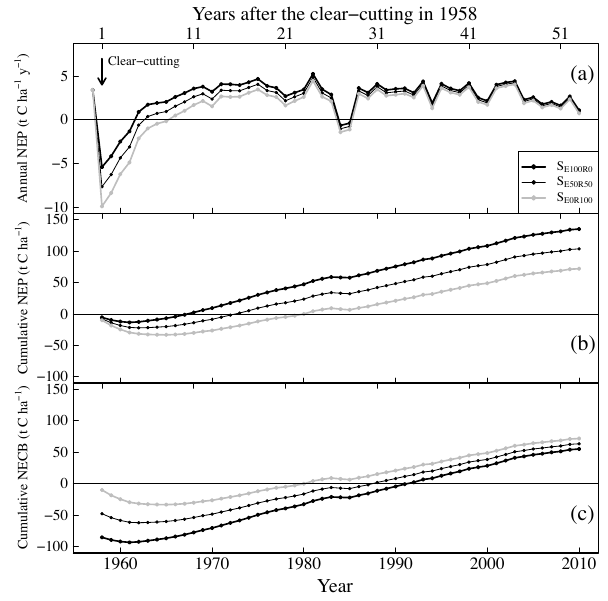
Figure 3. Time course of (a) annual net ecosystem production (NEP), (b) cumulative NEP, and (c) cumulative net ecosystem car- bon balance (NECB) at the Tomakomai site. These were simulated on the basis of the four treatment scenarios for clear-cutting and residues. Clear-cutting was not implemented in the non-disturbance scenario. S E0R100 : emission of logs 0%, that of residues 100%; S E50R50 : emission of logs 50%, that of residues 50%; S E100R0 : emission of logs 100%, that of residues 0%.